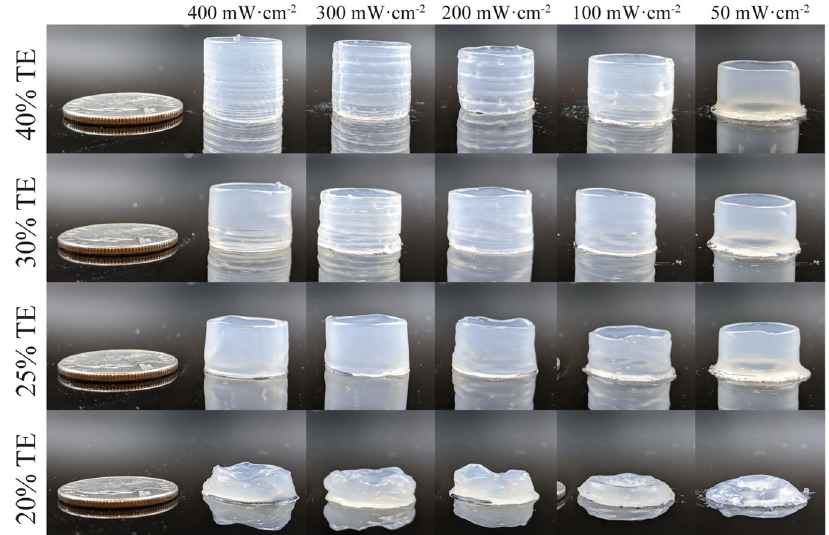
Fig. 5 Effect of UV power on printed object height at selected thiol-ene weight fractions. A simple hollow cylinder with a diameter of 15 mm and desired height of 10 mm used as a benchmark for the tests (Supplementary Fig. 7). For the wall thickness we used single pass of 25G (0.437 mm) nozzle per layer with a constant speed of 5 mm s − 1 and layer height of 0.35 mm. We use a quarter for scale on the left. Detailed print parameters listed in the Supplementary Table 3.